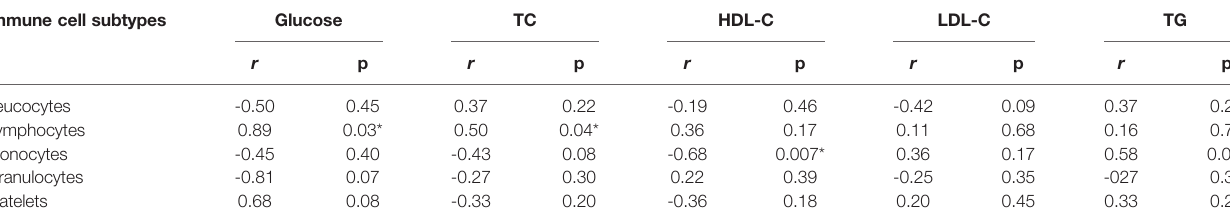
TABLE 3 | Correlations between immune cell subpopulations and biochemical parameters in pregnant control women (n = 35). Immune cell subtypes Glucose